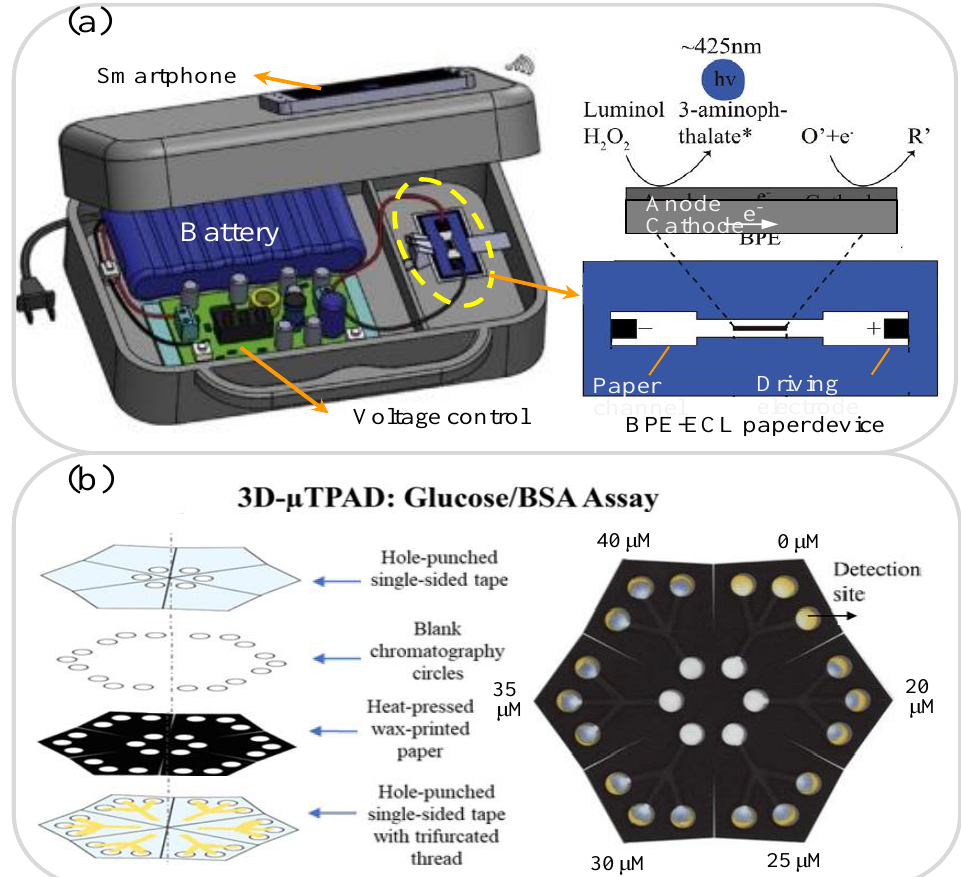
Figure 2. ( a ) P-BPE-ECL system and BPE-ECL paper device. Reprinted with permission from ref. [93]. Copyright 2016 Elsevier. ( b ). 3D-μTPAD platform with colorimetric detection for glucose in artificial urine samples. Reprinted with permission from ref. [103]. Copyright 2019 Wiley.